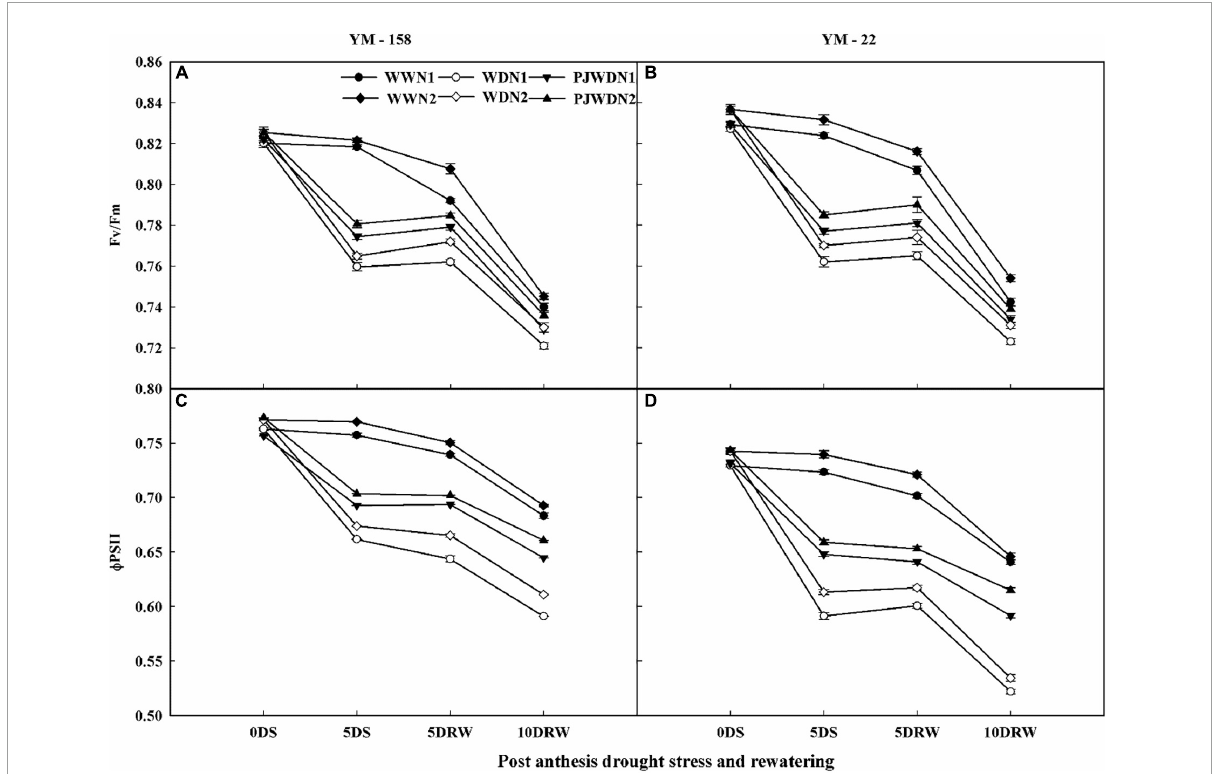
FIGURE4 Effects of pre-drought priming on the quantum efficiency of the photochemical reaction in PSII (Fv/Fm) and the quantum yield of the PSII electron transport ( (cid:56) PSII), in response to post-anthesis drought stress under two nitrogen (N) rates (N1,180 and N2, 300) in Yangmai-158 (A,C) and Yangmai-22 (B,D) wheat cultivars. Treatments: WW (control), no priming at jointing + no post-anthesis drought stress; PJWD, priming at jointing + post-anthesis drought stress; and WD, no priming at jointing + post-anthesis drought stress. Pre-drought priming was completed during the jointing stage, and post-anthesis drought stress was applied from 7 to 14 days after anthesis. The horizontal axis shows the time course of the sampling: 1 day before drought stress (0DS), 5 days after of drought stress (5DS), and 5 and 10 days after re-watering (5DRW and 10DRW). Each vertical bar above the mean value indicates the standard error of three replicates ( n = 3) by using three-way ANOVA at P <